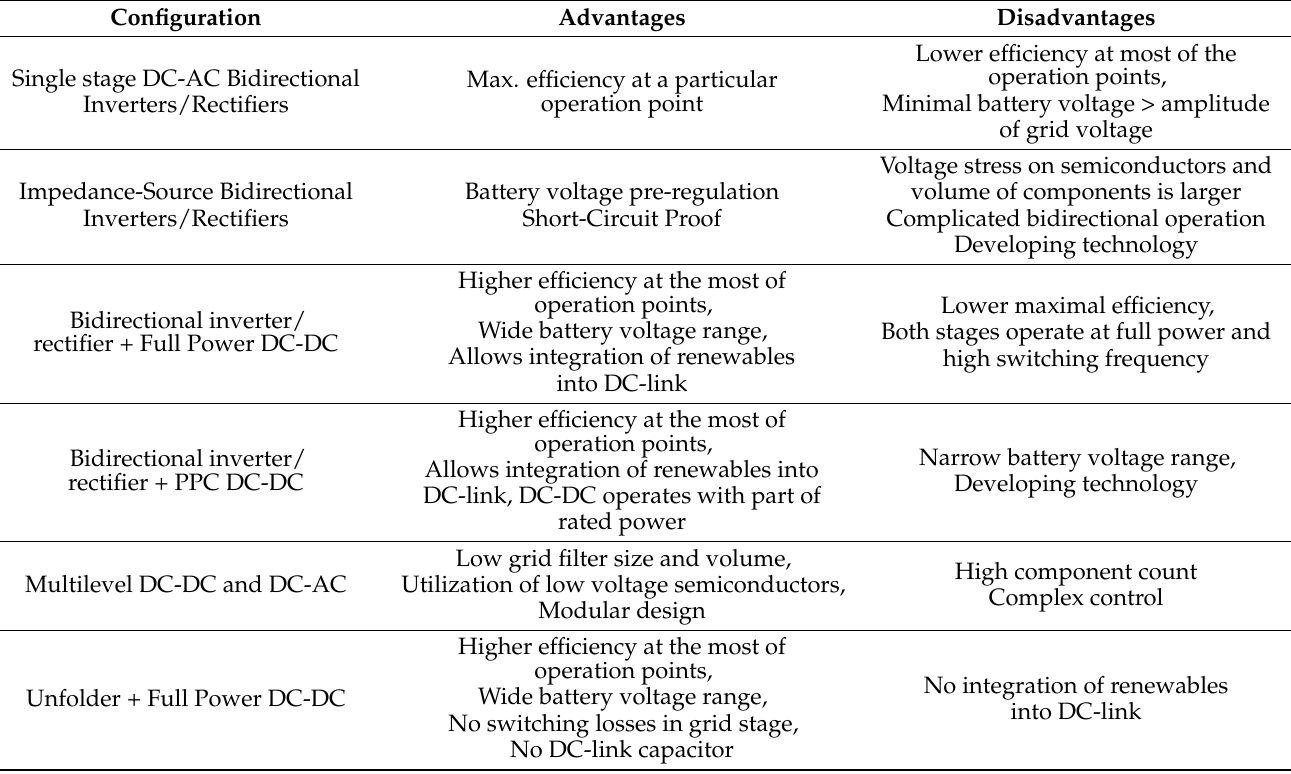
Table 4. Promising combination of converters to form BESS grid